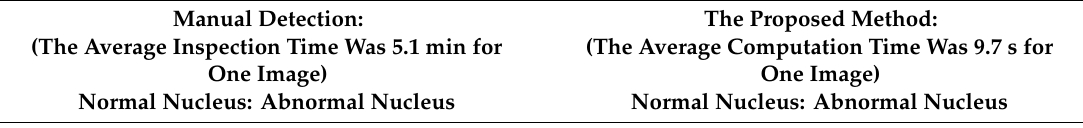
Table 3. The ratios between manual detection and the proposed